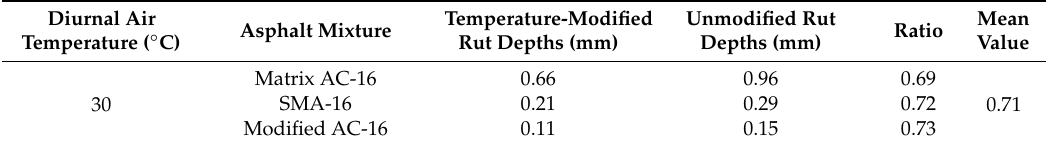
Table 6. Prediction of modified and unmodified rut depths and their ratios.